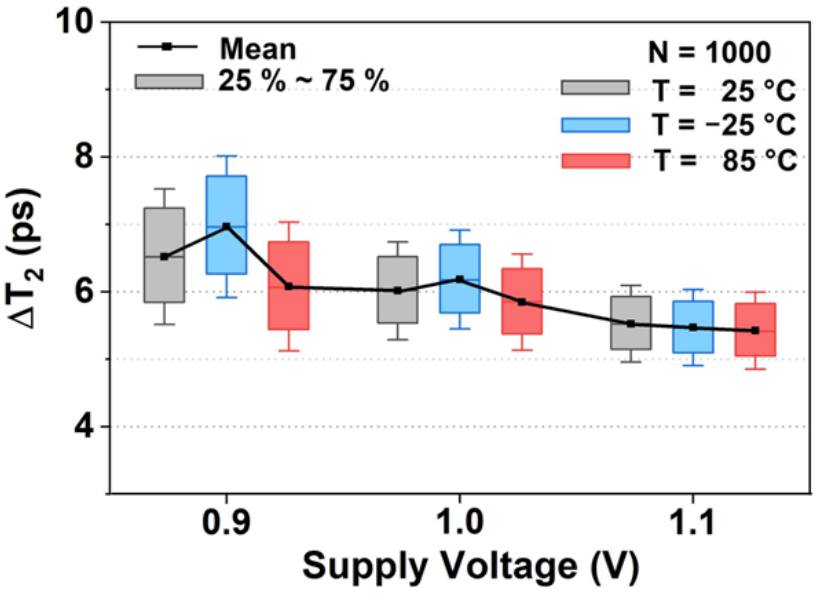
Figure 9. Mean and standard deviation of ∆ T 2 (rising edge of Φ DA minus the rising edge of Φ EN ) under supply voltage and temperature variation.